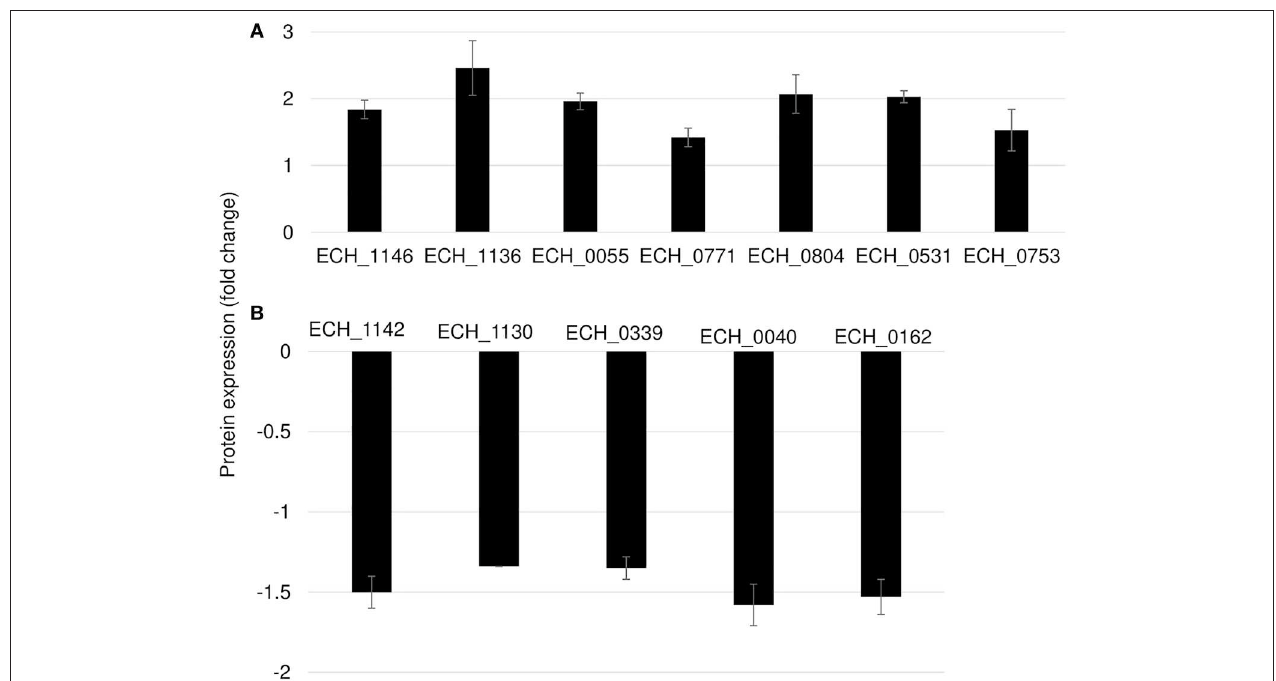
FIGURE 6 | Differentially expressed proteins in mutant ECH_0490. (A) Upregulated proteins, (B) downregulated proteins. Protein expression was determined by comparing the expression values of mutant ECH_0490 and wildtype. The GenBank numbers are listed in Table 2 . Fold changes were considered significant with < 1% FDR at protein level and with a p -value was than 0.05.